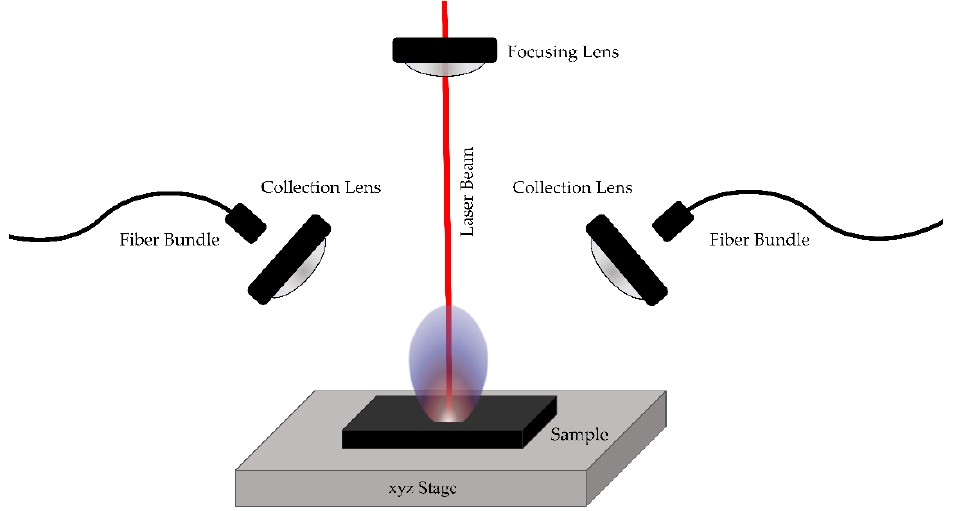
Figure 1. Laser-Induced Breakdown Spectroscopy (LIBS) experimental setup.